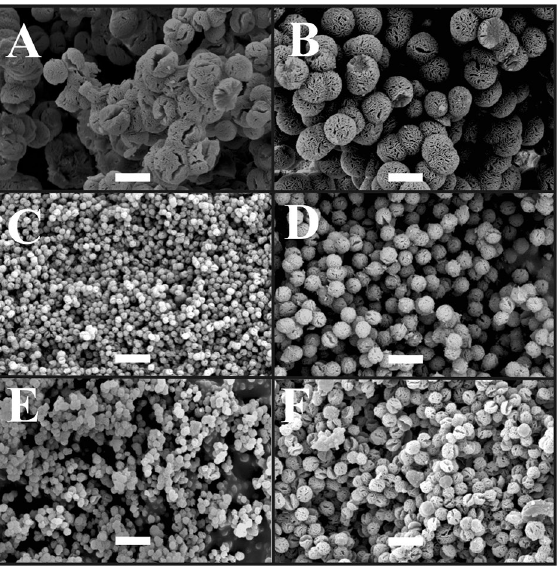
Figure 1. Exemplary scanning electron microscopy (SEM) microphotographs of the obtained stereocomplexed microparticles with low molecular mass—sc-PLA (lmm) ( A ) or with medium molecular mass—sc-PLA (mmm) ( B ), which were loaded with S. cadmica aerial part extract—sc-PLA-SCAPE (lmm) ( C ) and sc-PLA-SCAPE (mmm) ( D ) or with S. cadmica root extract sc-PLA-SCRE (lmm) ( E ) and sc-PLA-SCRE (mmm) ( F ). The scale bar denotes 5